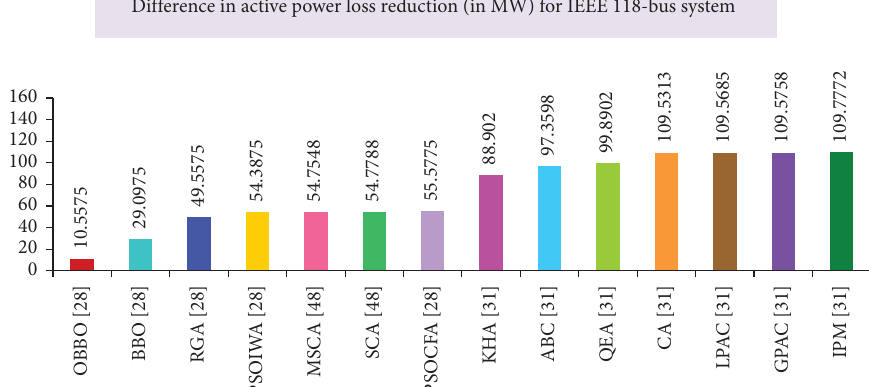
Figure 14: Active power loss reduction diference (in MW) of the proposed technique against other optimization methods reported in the literature for the IEEE 118-bus system.